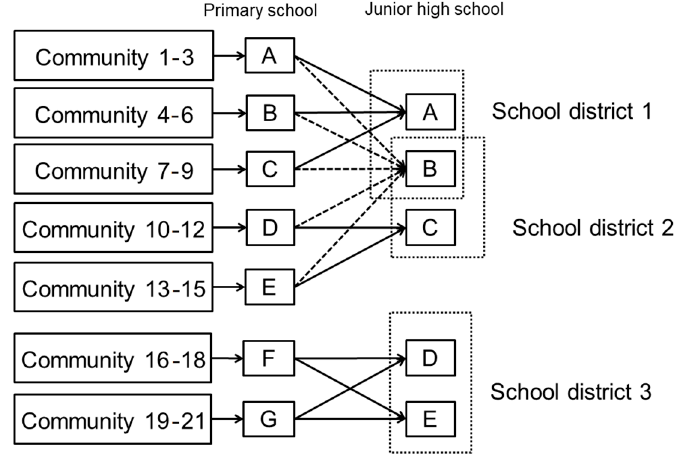
Figure 1. Models of multi-school zoning in Chengdu.